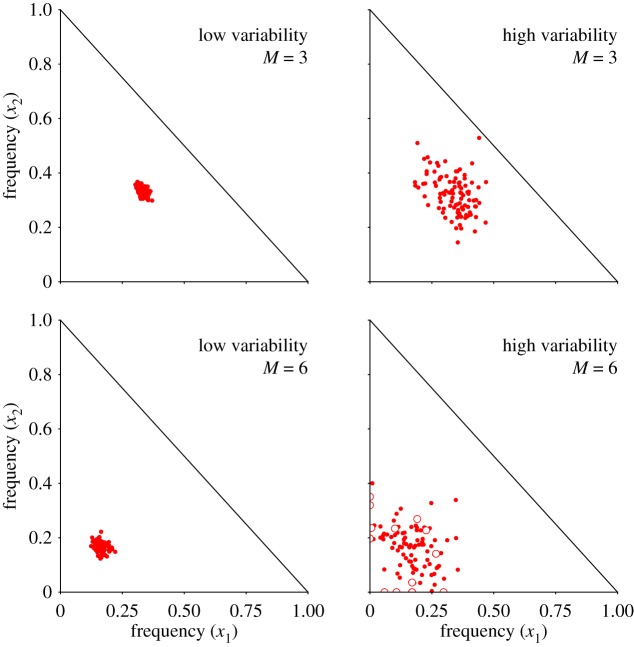
Fixed points computed from samples of mortality rates. Due to the assumption of fixed population size, for a population with M = 3 mating types there are only two free variables, the frequency of mating types 1 and 2 (x1 and x2, respectively). Similarly, for a population with M = 6 mating types there are five free variables. For clarity, we plot the position of the fixed points x* = (x1, …, x5) as a projection in (x1, x2) plane. Mortality rates are drawn from a normal distribution with low variance 0.001 (left) and high variance 0.005 (right) and the clonal rate is set to c = 0.9. The fixed point destabilizes as the fitness variability increases (left to right). Frequencies are pushed towards the extinction boundary as the number of mating types M increases (top to bottom). Fixed points that lie on an extinction boundary (xi = 0) in the higher-dimensional space (i.e. where one or more mating types is extinct) are indicated as empty circles.